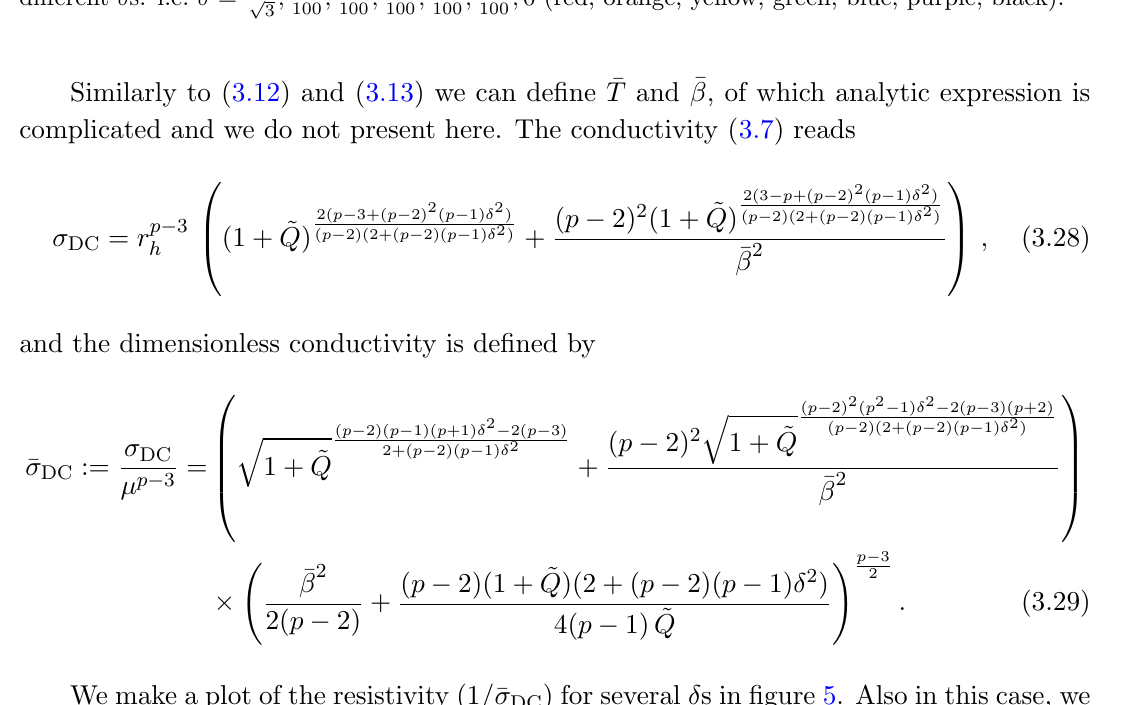
Figure 5 . Resistivity ( (cid:26) ) vs temperature. (cid:22) (cid:12) = 0 : 1(a), 10(b) for p = 3. Various colors represent di(cid:11)erent (cid:14) s. i.e. (cid:14) = 1 p